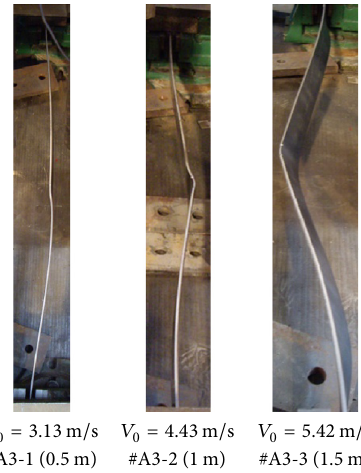
Figure 9: Deformation modes of #A3 (𝛼 = 10, 𝛽 = 20) .